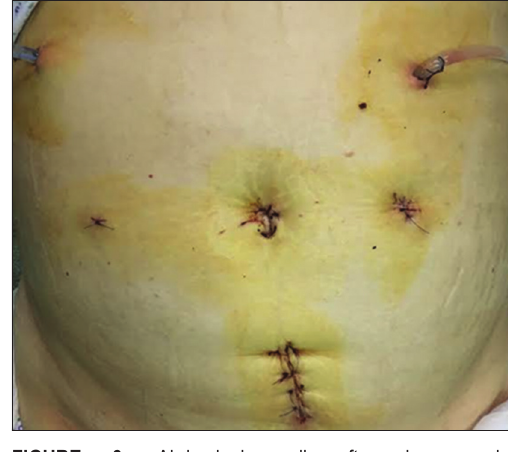
FIGURE 3. Abdominal wall after laparoscopic pancreaticoduodenectomy.